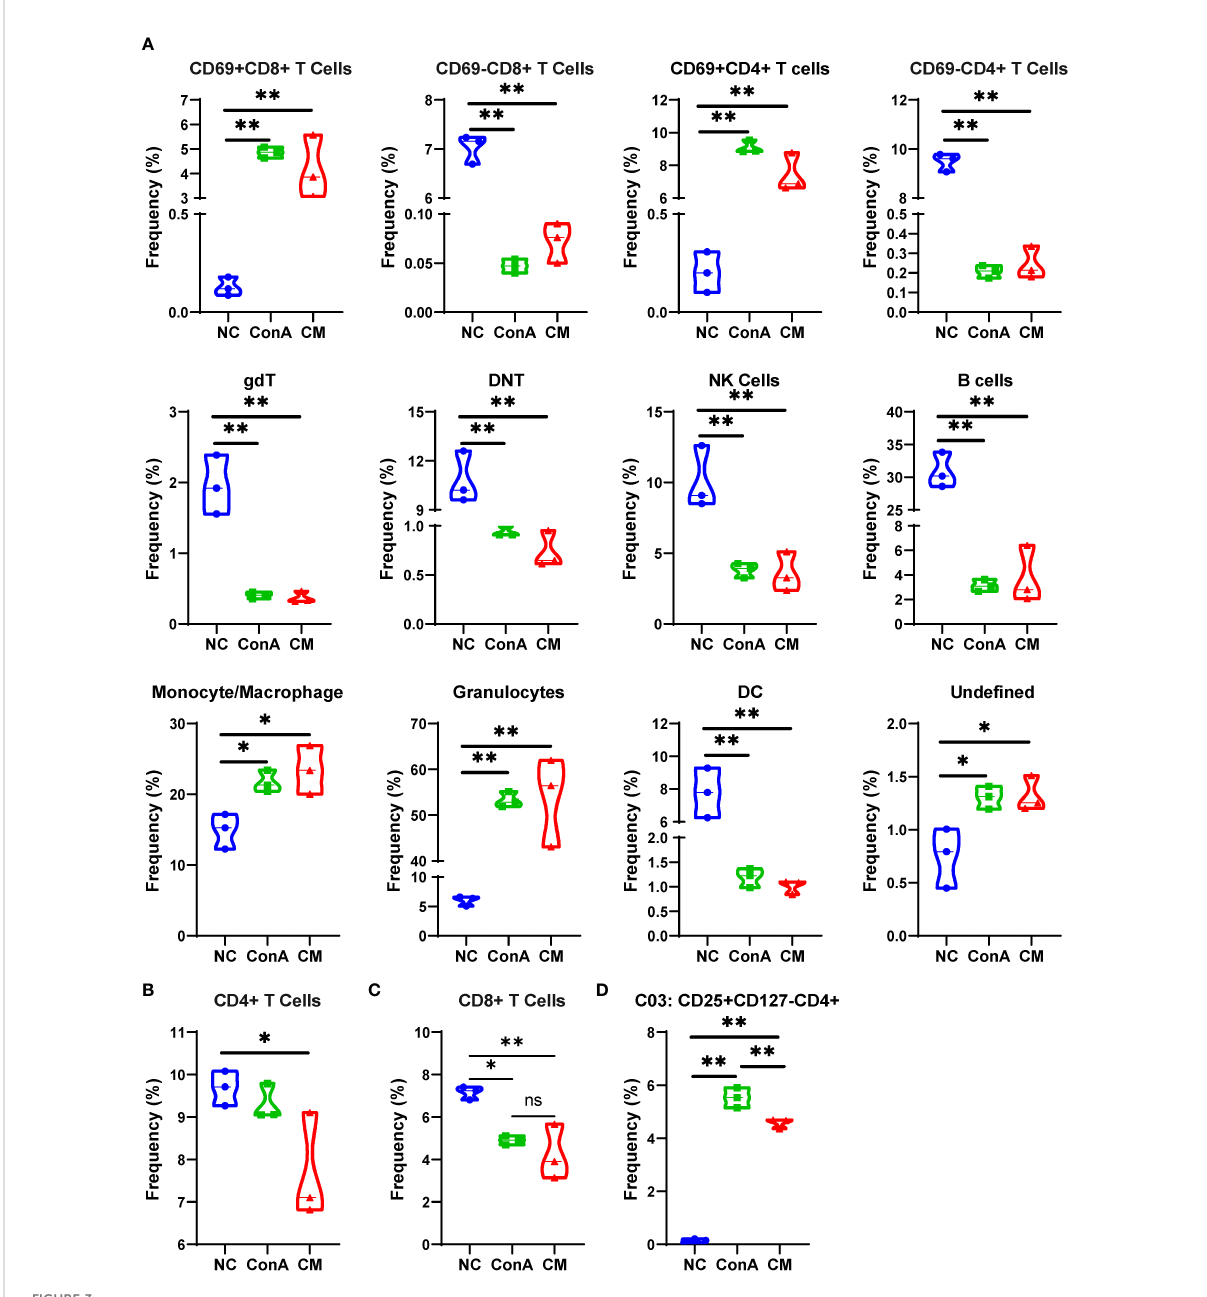
FIGURE 3 Major cells type analysis of different groups among immune cells. (A) The percentages of different groups in the NC, ConA, and CM groups among CD45 + immune cells in the liver tissue. (B – D) The cell frequency of CD4 + and CD8 + T cells and C03 cells in the NC, ConA, and CM groups among all immune cells in the liver tissue (n = 3 per group; ns, not statistically signi fi cant, * p < 0.05, ** p < 0.01). Data are presented as mean ±